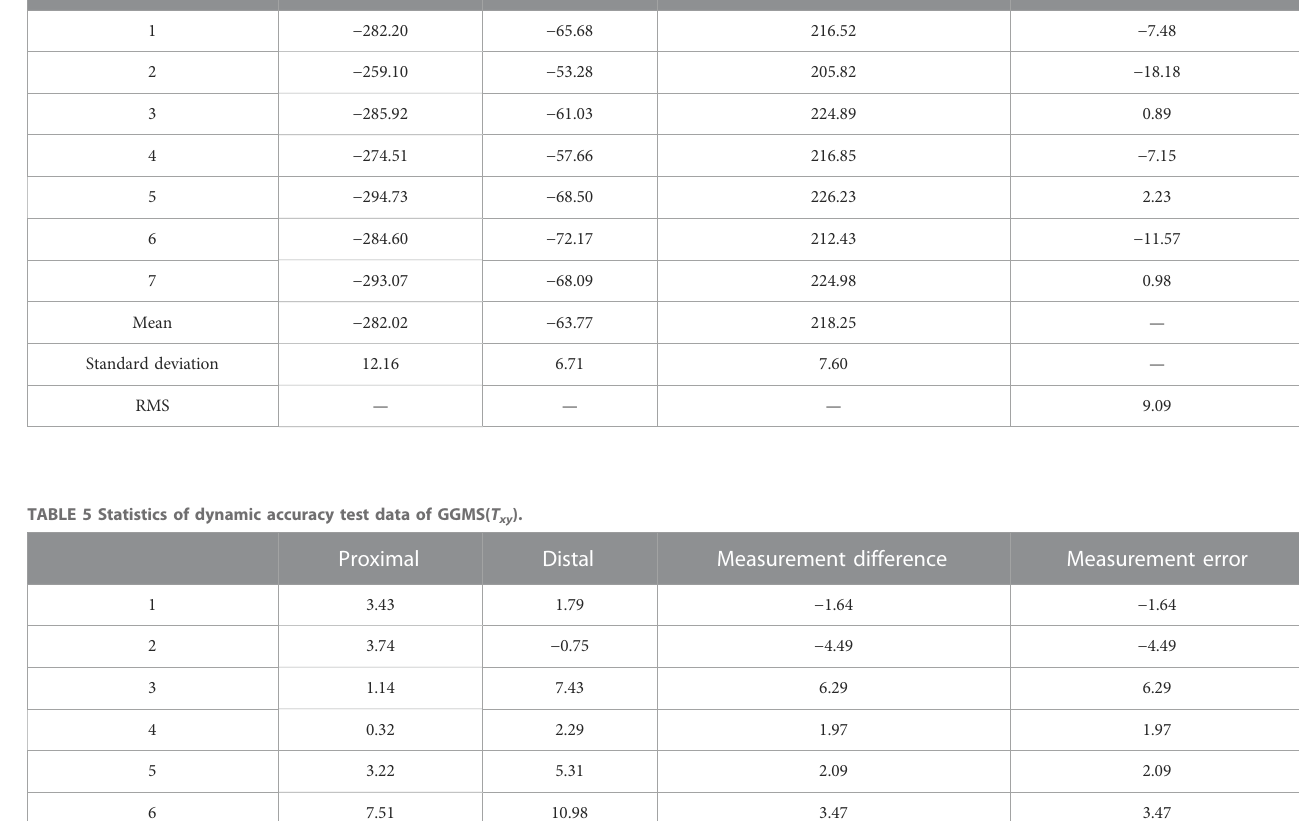
TABLE 4 Statistics of dynamic accuracy test data of GGMS( T uv ). Proximal Distal Measurement difference